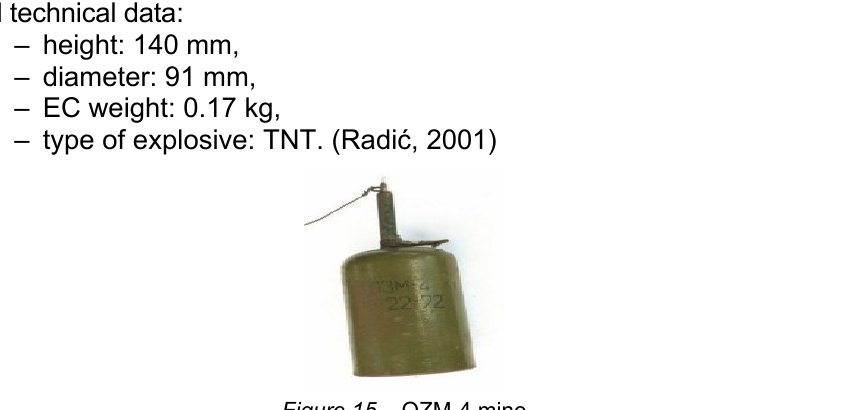
Figure 15 – OZM-4 mine Рис . 15 – Мина OZM-4 Слика 15 – Мина